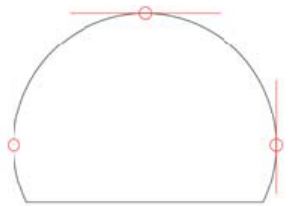
Fig. 3: Simplified section and elements of the structural lines In a second step, a 2D plan containing all the elements present in the tunnel (fire extinguishers, lights, panels, etc.) was carried out, as well as a 3D modeling of a section of the